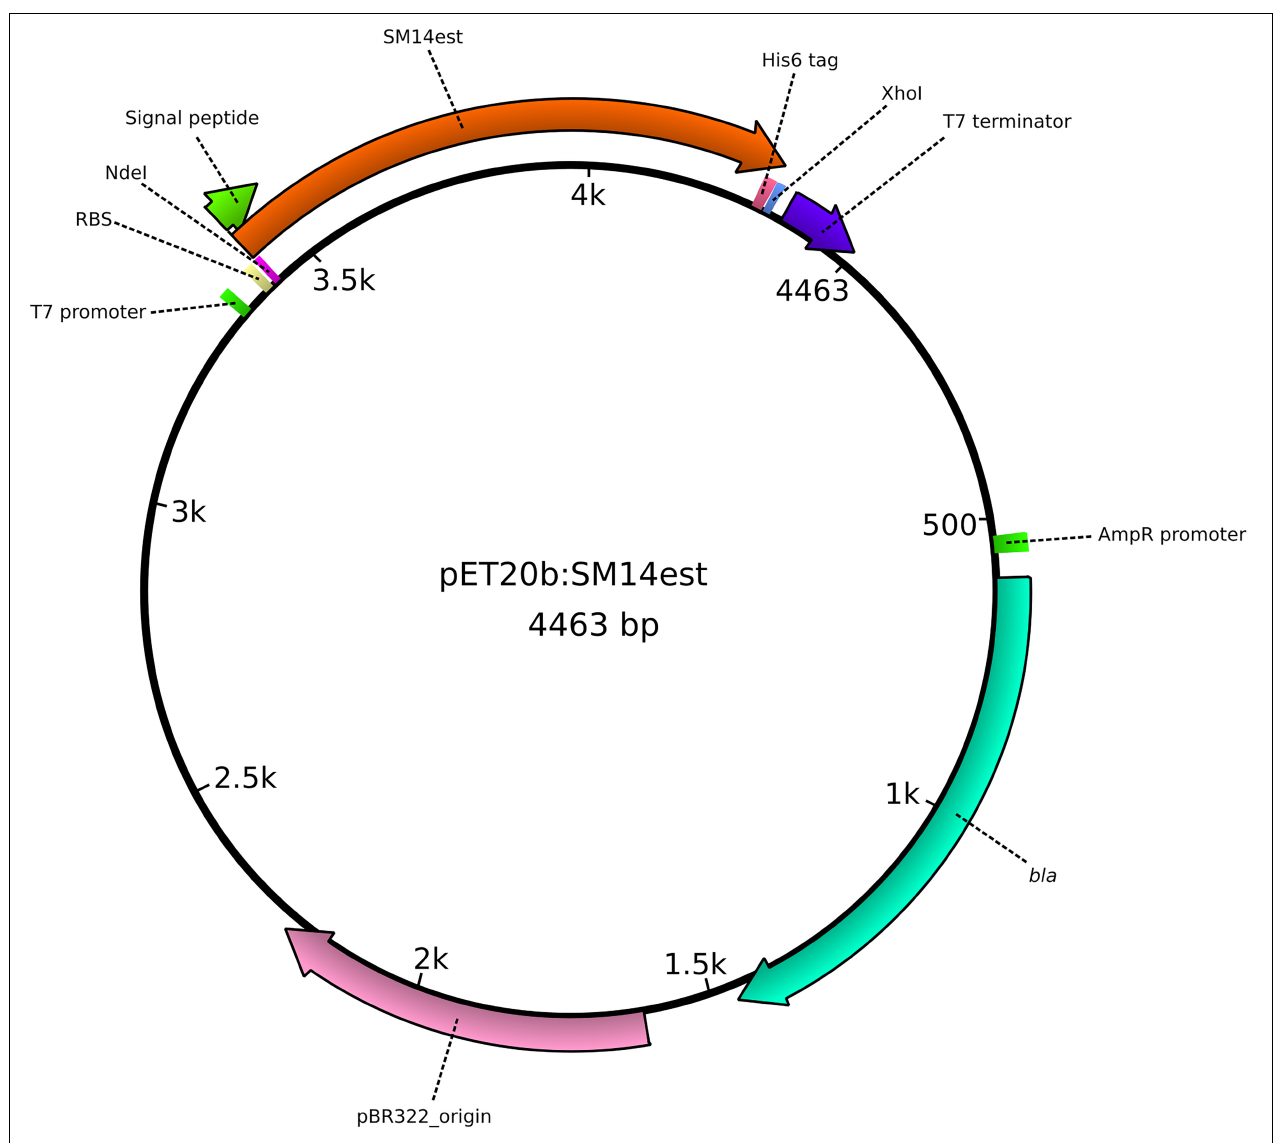
FIGURE 1 | Graphical representation of the pET20b:SM14est plasmid, constructed for the heterologous expression of the SM14est protein in Escherichia coli . The insert (SM14est) and other important features of the plasmid are represented and labeled accordingly.